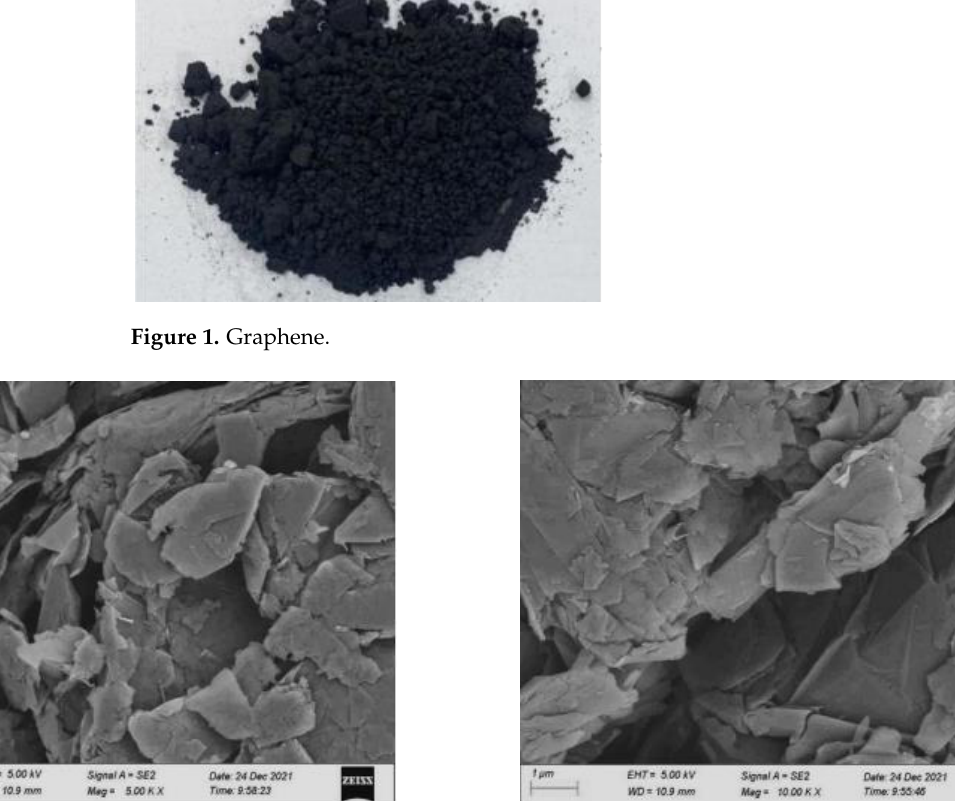
Figure 2. Micromorphology of Graphene. ( a ) 5000 times. ( b ) 10,000 times.